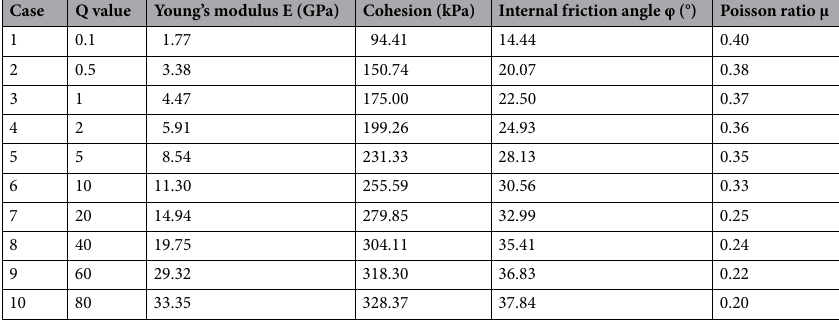
Table 8. Mechanical parameters of rock mass with different Q values.